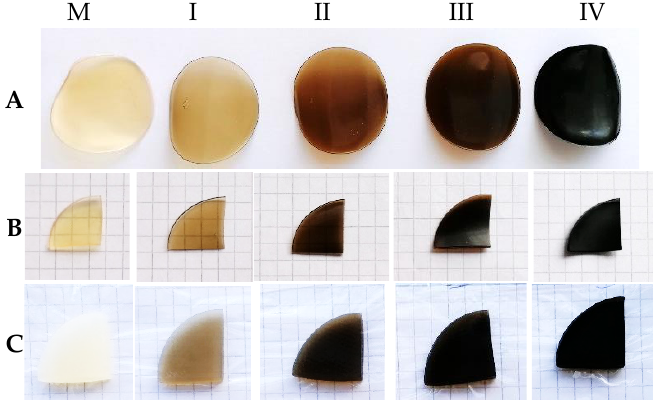
Figure 1. Hydrogel samples after drying in figure ( A ), being prepared for swelling in figure ( B ), and after 48 h of swelling in figure ( C ); I, II, III, and IV with increasing GO concentration, and the control sample M.